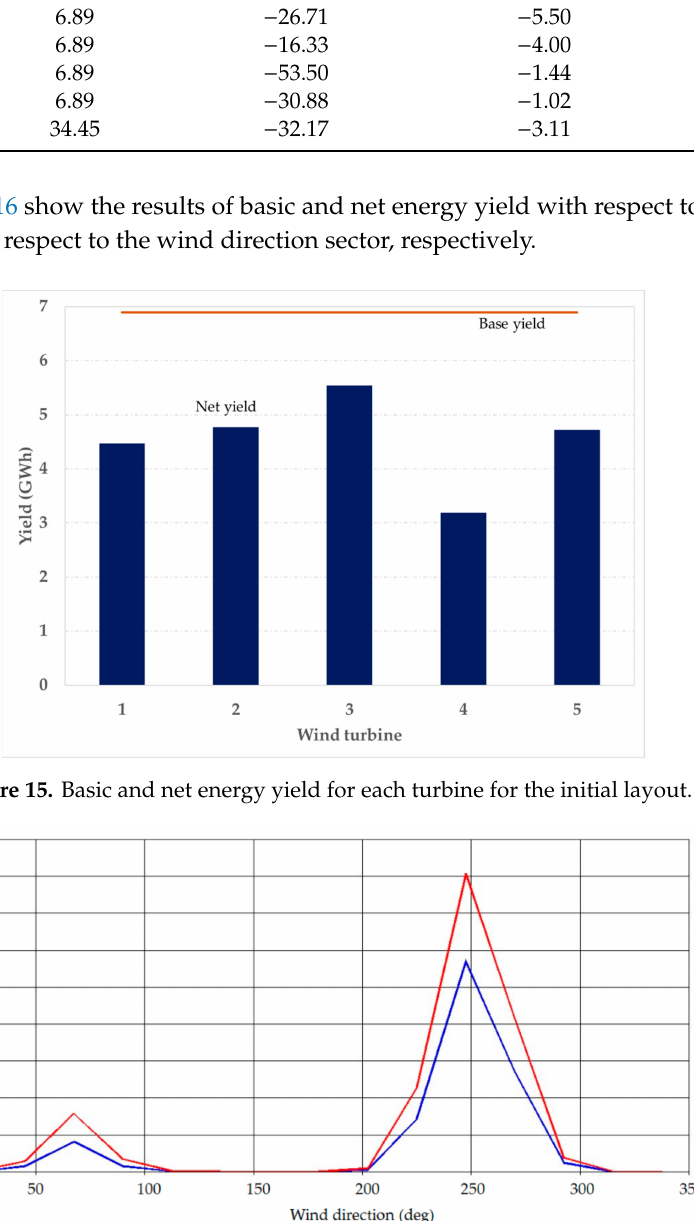
Figure 16. Basic and net energy yield with wind direction for the initial